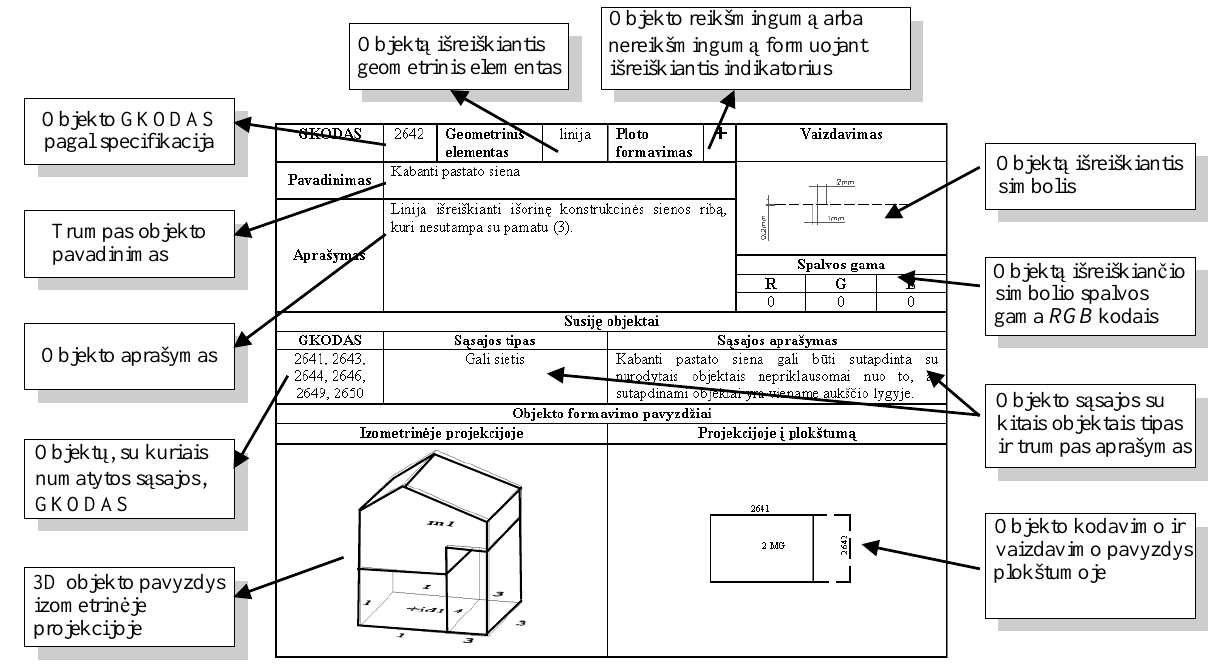
Fig 3 . Structure of the geoobject card of a great-scale digital